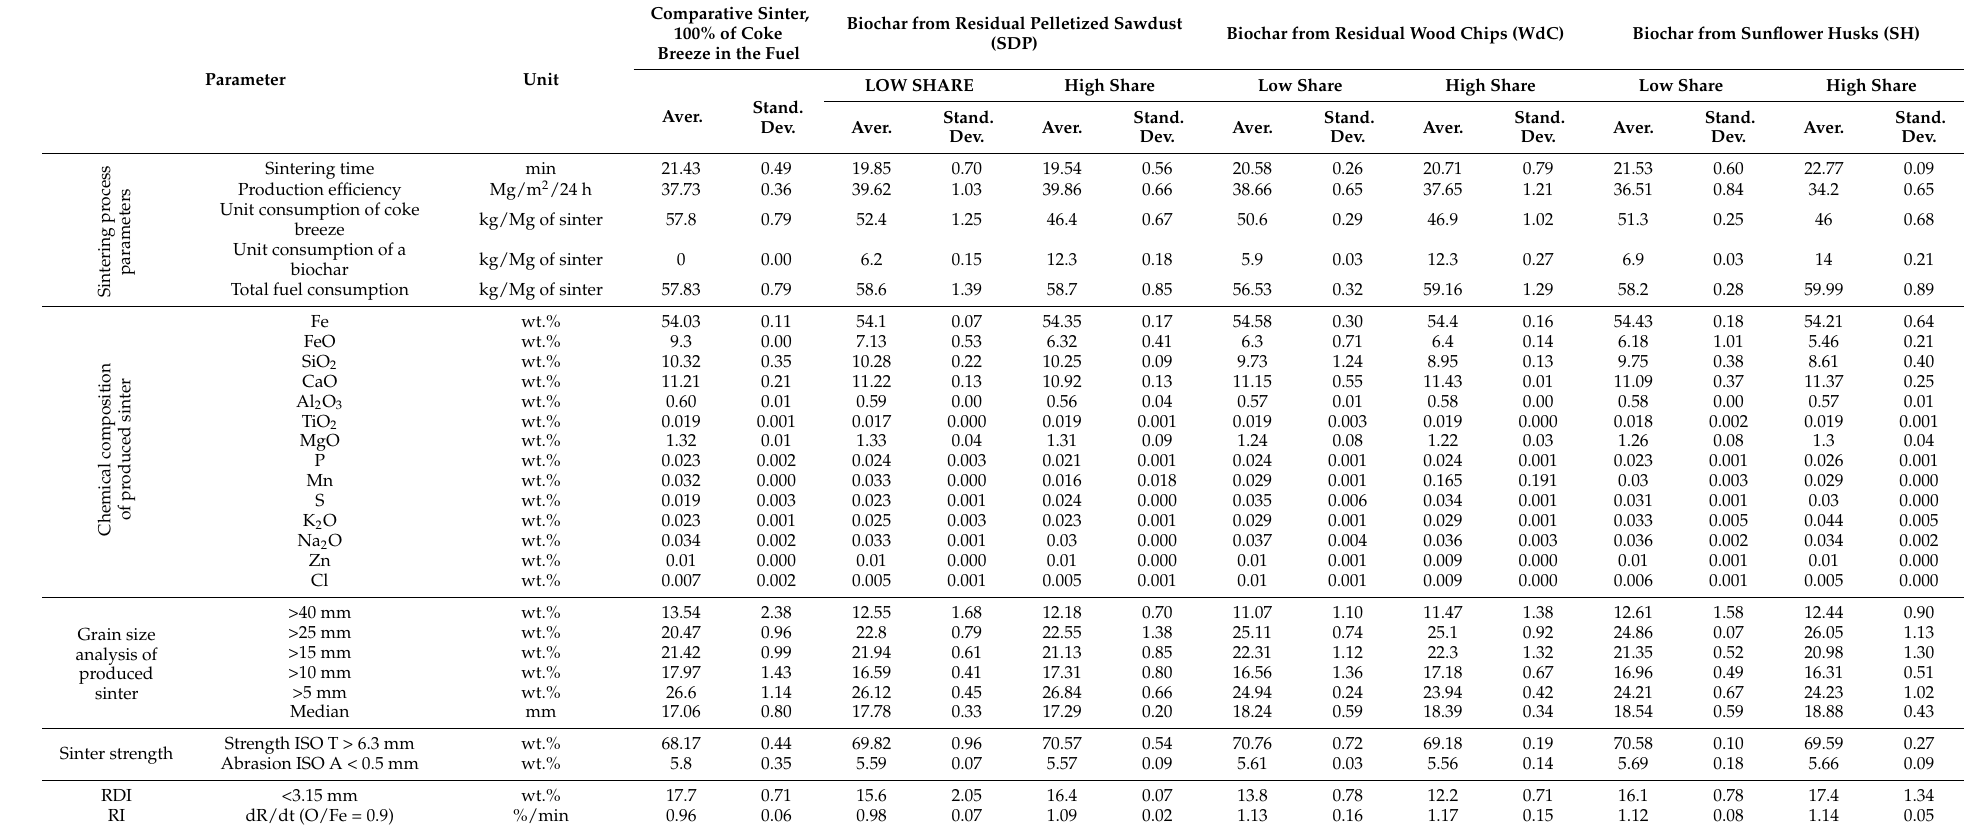
Table A1. Detail results of the laboratory sintering tests with low and high share of biochar in